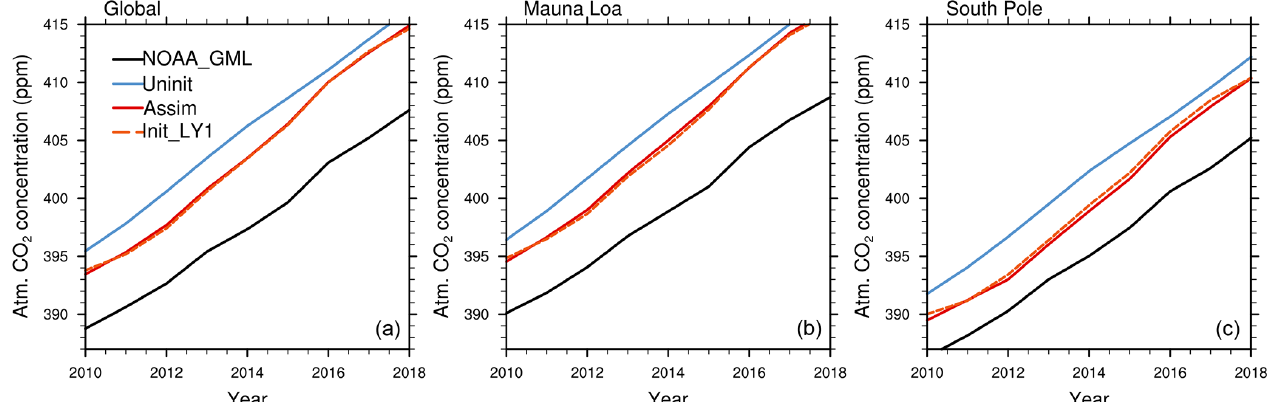
Figure A4. Atmospheric CO 2 concentration from the assimilation and initialized simulations at a lead time of 1 year together with NOAA_GML observations (Dlugokencky and Tans, 2020) over the last 10 years. The time series are original model outputs and concatenated according to the lead time of years.